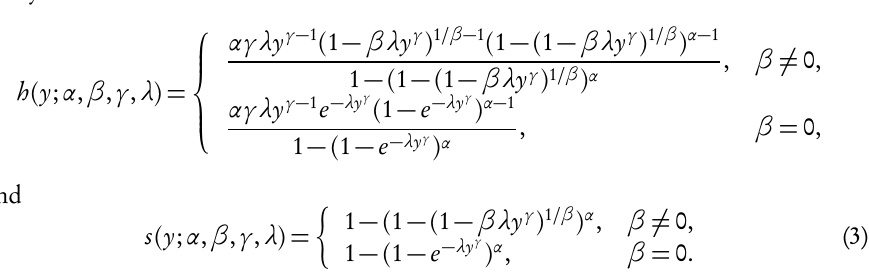
Figure 1 – The PDFs of the EEW for different values of α , β and γ with λ = 1. The hazard rate and survival function of the EEW distribution are given by, respec-